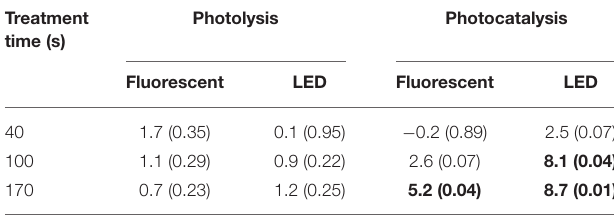
TABLE 3 | Summary of NH 3 mitigation with UV-A